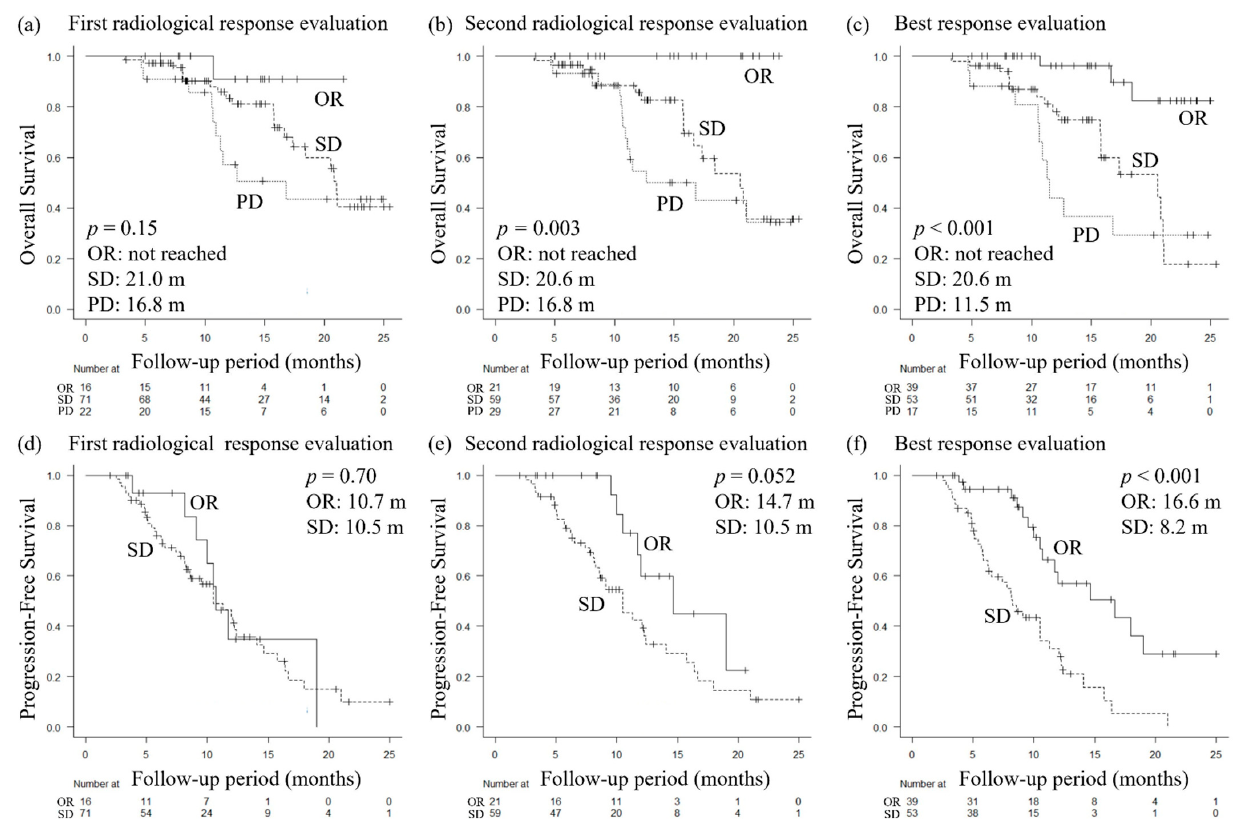
Figure 2. Comparison of overall survival (OS) and progression-free survival (PFS) by radiological response at the first, second, and best response evaluations by Response Evaluation Criteria in Solid Tumors (RECIST). ( a ) OS at the first response (objective response (OR) not-reached, SD 21.0 months, PD 16.8 months, p = 0.15). ( b ) OS at the second response (OR not-reached, SD 20.6 months, PD 16.8 months, p = 0.003). ( c ) OS at the best response (OR not-reached, SD 20.6 months, PD 11.5 months, p < 0.001). ( d ) PFS at the fi rst response (OR 10.7 months, SD 10.5 months, p = 0.70). ( e ) PFS at the second response (OR 14.7 months, SD 10.5 months, p = 0.052). ( f ) PFS at the best response (OR 16.6 months, SD 8.2 months, p < 0.001).